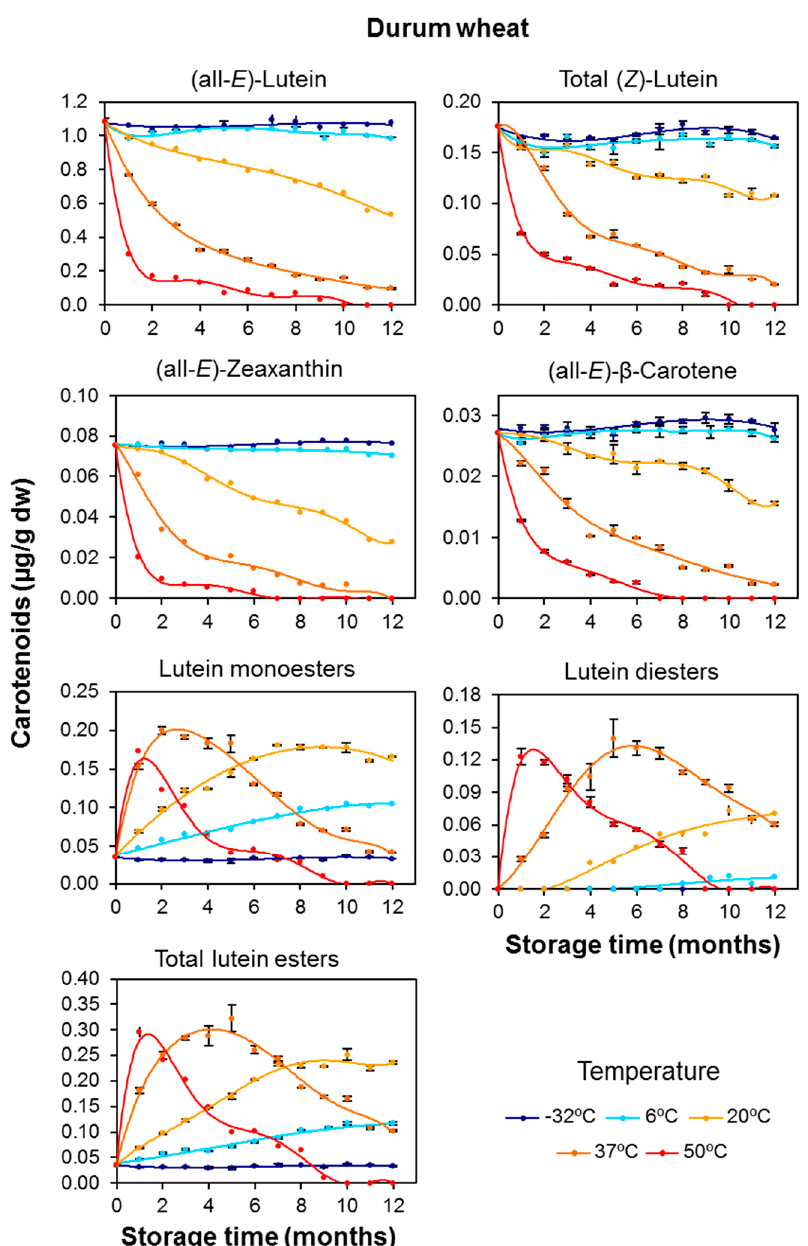
Figure 2. Evolution of the individual carotenoid content and esterified fractions ( µ g/g dry weight) in durum wheat (Don Pedro variety) whole-grain flours during long-term storage under temperature controlled conditions ( − 32, 6, 20, 37 and 50 ◦ C). The values shown are the mean and standard error ( n = 5 for the starting sample, n = 3 for the rest of the